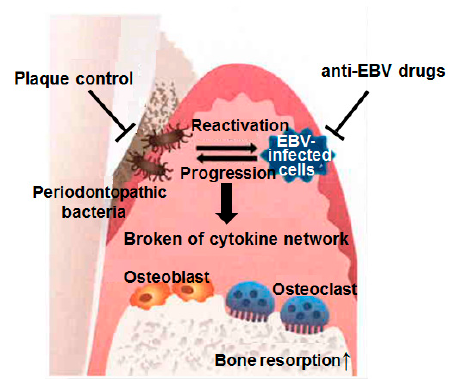
Figure 4. Microbial synergy by EBV–bacterial interaction in periodontitis pathogenesis. There is a possibility that a “negative chain reaction” by EBV and periodontopathic bacteria contributes to the etiology of severe periodontitis. It is expected that future basic clinical studies will determine whether the concept of a “periodontopathic virus” is applicable to the etiology of